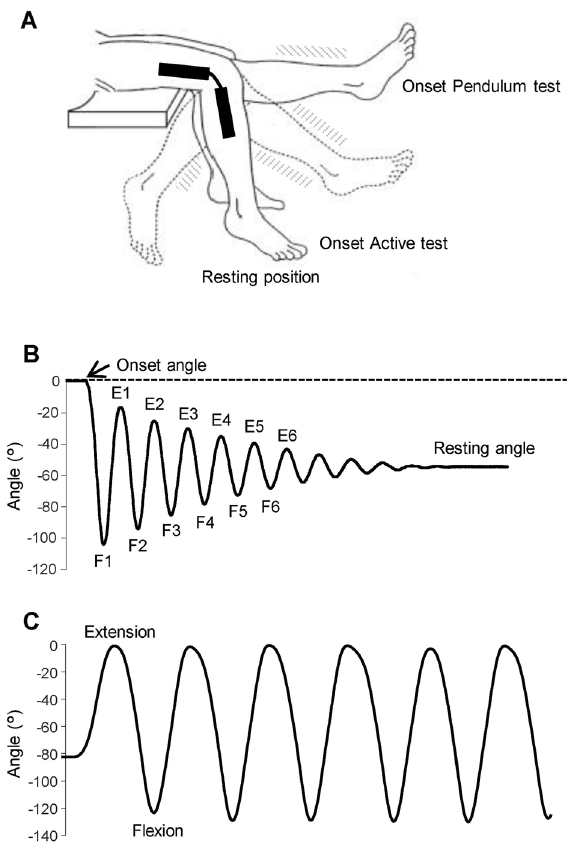
Figure 1. Experimental setup and typical kinematic trajectories in passive and active protocols. ( A ) Leg oscillations during passive pendulum test and active flexion–extension movements. ( B ) Knee angular displacement during the pendulum test, showing onset angle corresponding to the maximum leg extension, resting angle corresponding to the leg resting position and the first 12 hemicycles (flexions: F1, F2, .. F6; extensions E1, E2, .. E6). ( C ) Knee angular displacement during voluntary flexion and extension movements with the onset angle corresponding to the resting position. An electrogoniometer recorded the angular displacements of the knee and two couples of surface electrodes recorded the EMG activity of the Rectus Femoris and Biceps